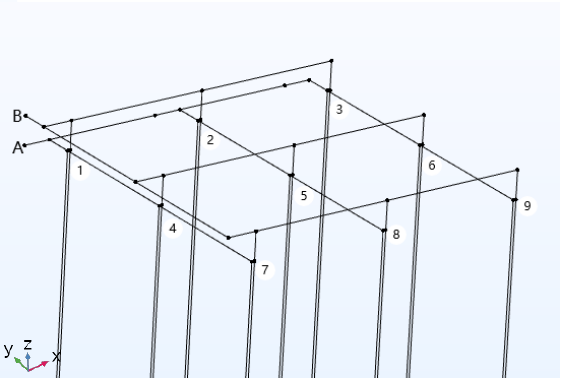
Figure 6. Simulated rock mass with U pipes and model specifications. ( A ) rock mass without a frac- ture (NF). ( B ) rock mass with a single horizontal fracture (F1). ( C ) rock mass with two horizontal fractures (F2).